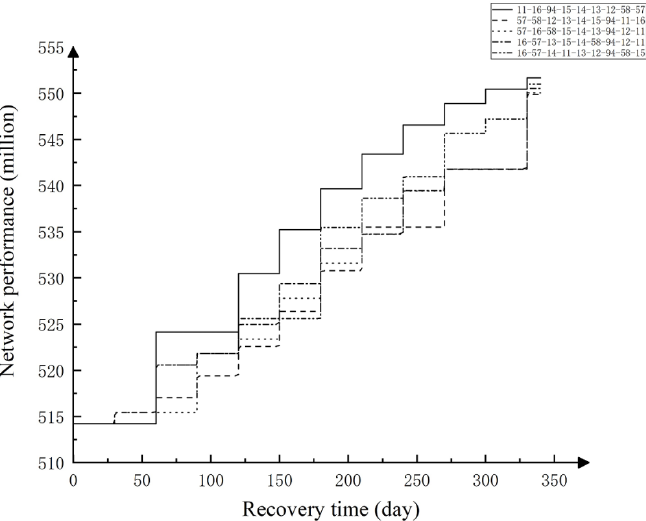
Figure 14. Network performance variation with different maintenance orders.